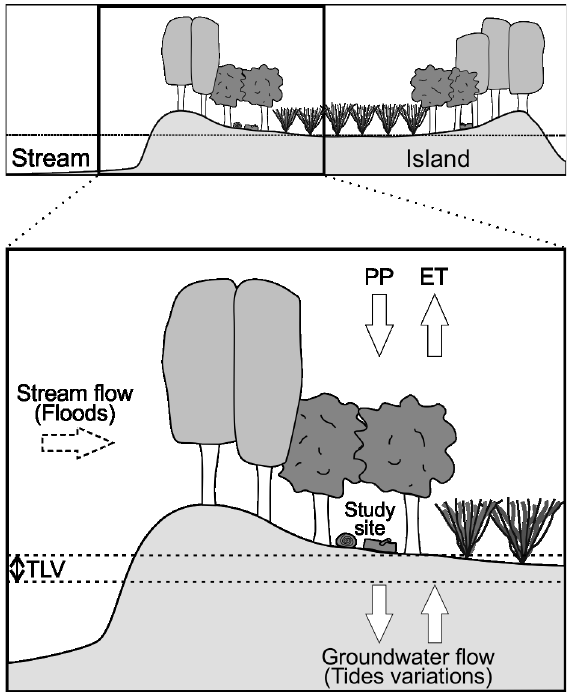
Figure 2. Schematic representation of the island topography showing the study area, the principal water inputs, and tide level variations (TLV). Figure adapted from Kandus & Malvárez (2004) and Batzer & Boix (2016).